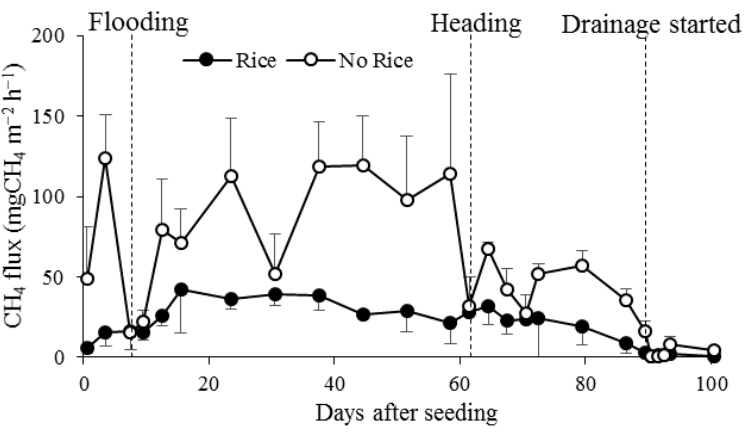
Figure 1. Seasonal CH emissions in paddy fields. Average CH 4 cropping rice fields in the Mekong Delta. Winter–Spring season (2017). The paddy fields did not receive rice straw incorporation. Error bars are s.d. (n = 3).